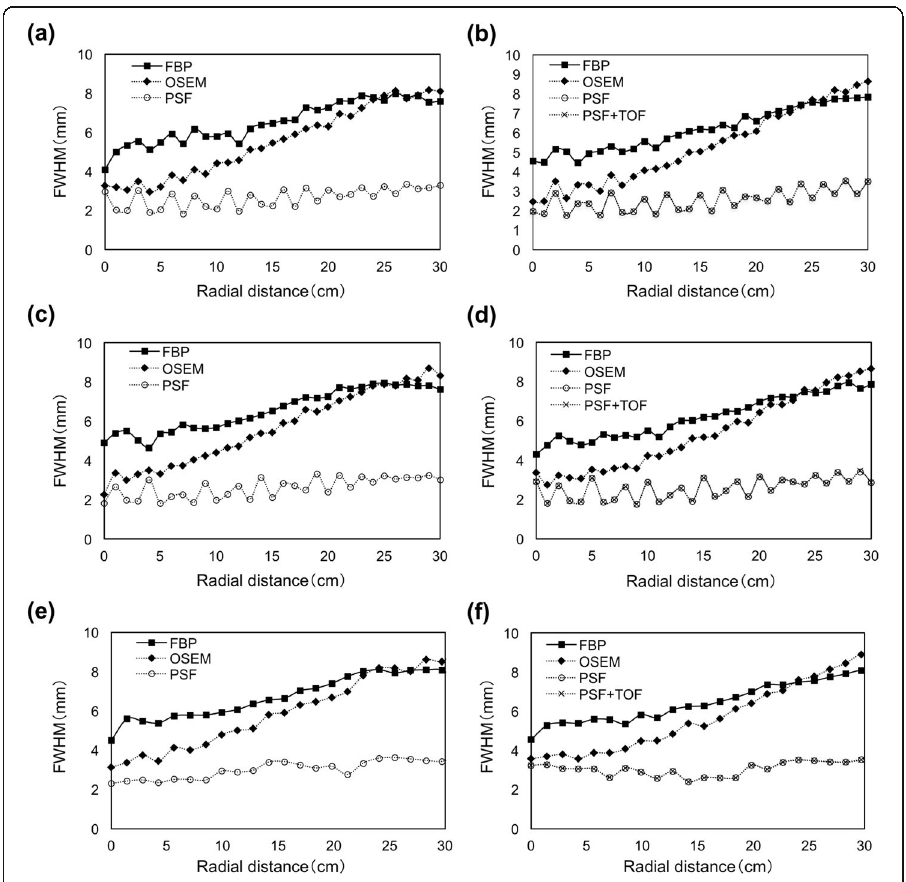
Fig. 2 Radial FWHM at different radial locations for x - ( a , b ), y - ( c , d ), and xy - ( e , f ) axes using Discovery 600 ( a , c , e ) and Discovery 710 ( b , d , f